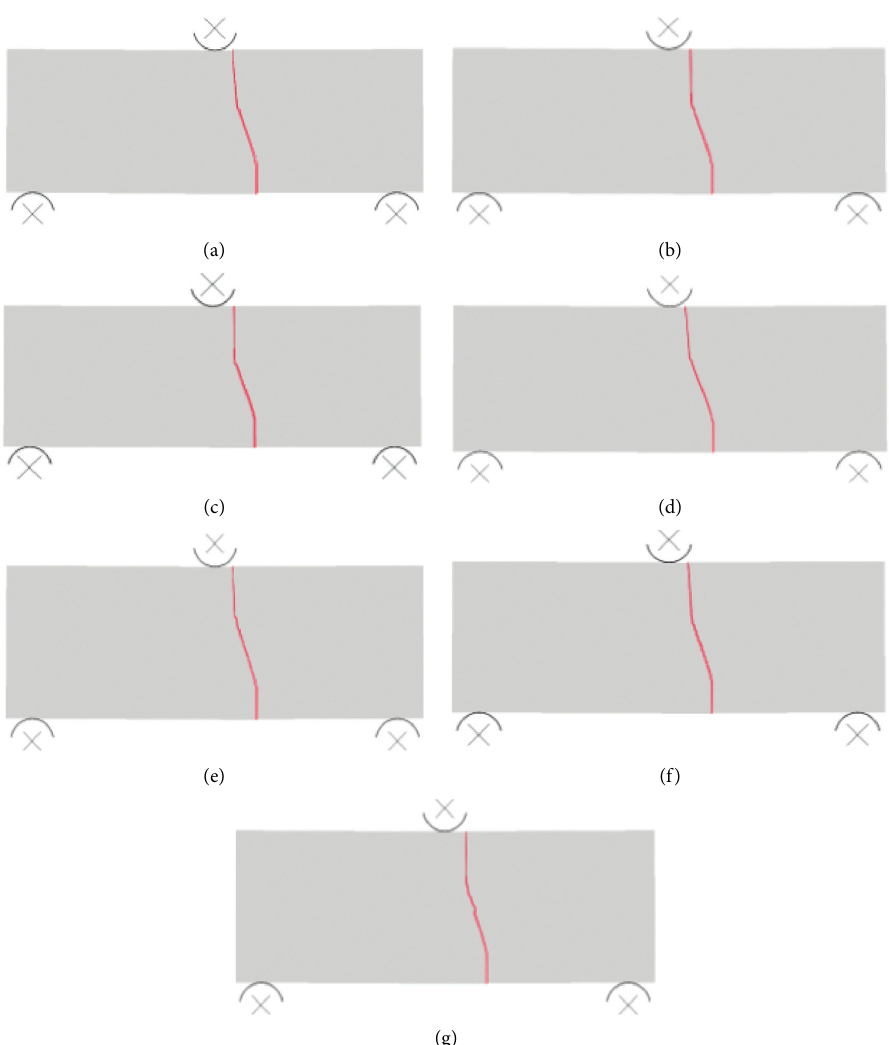
Figure 18: Crack patterns for the rock beams with the notch of 20% offset ratio for different mechanical parameters: (a) E � 20 GPa; σ max � 9MPa; G f � 100N/m; (b) E � 30GPa; σ max � 9MPa; G f � 100N/m; (c) E � 40GPa; σ max � 9MPa; G f � 100N/m; (d) E � 30GPa; σ max � 6MPa; G f � 100N/m; (e) E � 30GPa; σ max � 12MPa; G f � 100N/m; (f) E � 30GPa; σ max � 9MPa; G f � 80N/m; (g) E � 30GPa; σ max � 9MPa; G f �